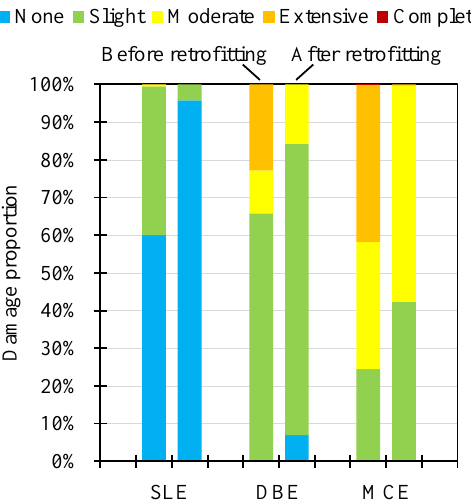
Figure 6. Average damage percentages of buildings under earthquakes.